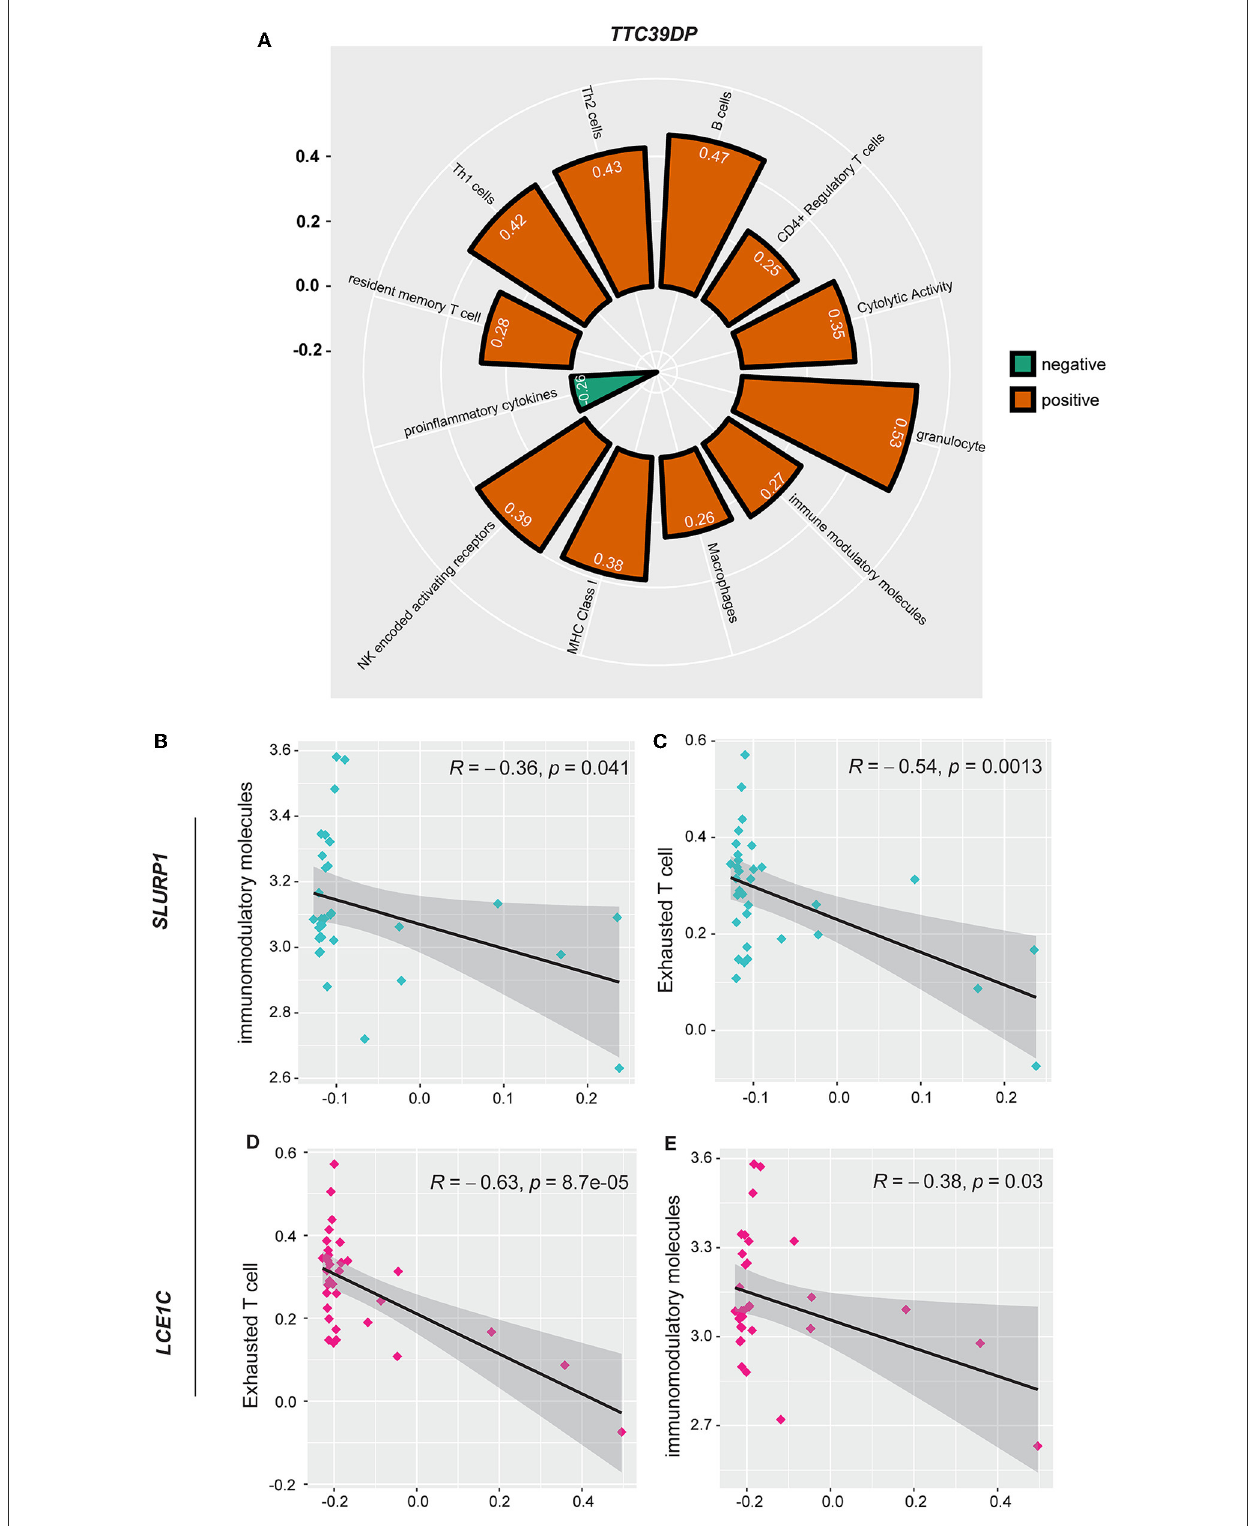
FIGURE5 Association between SLURP1 , LCE1C , and TTC39DP expression levels and immune signatures. (A) Significant correlation between TTC39DP expression levels and 12 immune signatures. (B) Significant correlation between SLURP1 expression levels with immunomodulatory molecules and (C) exhausted T cell. (D) Significant correlation between LCE1C expression levels with an exhausted T cell. (E) Immunomodulatory molecules. Pearson’s correlation coefficients ( R ) and P -values are